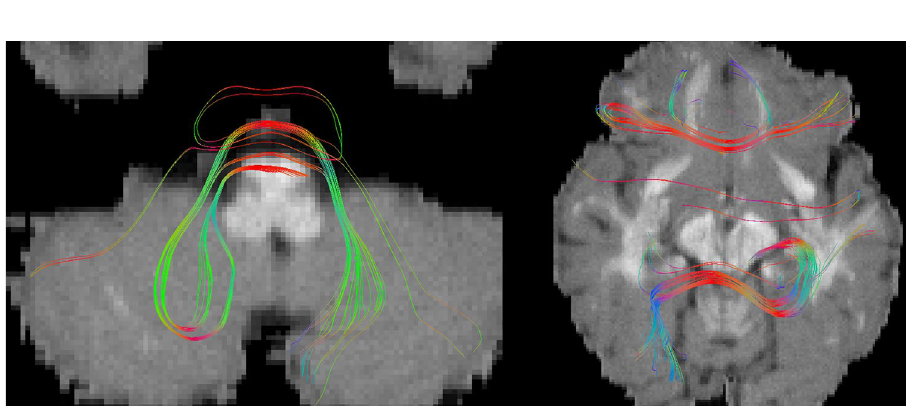
Figure 3. Examples of looping fibers that were hidden in the original GT